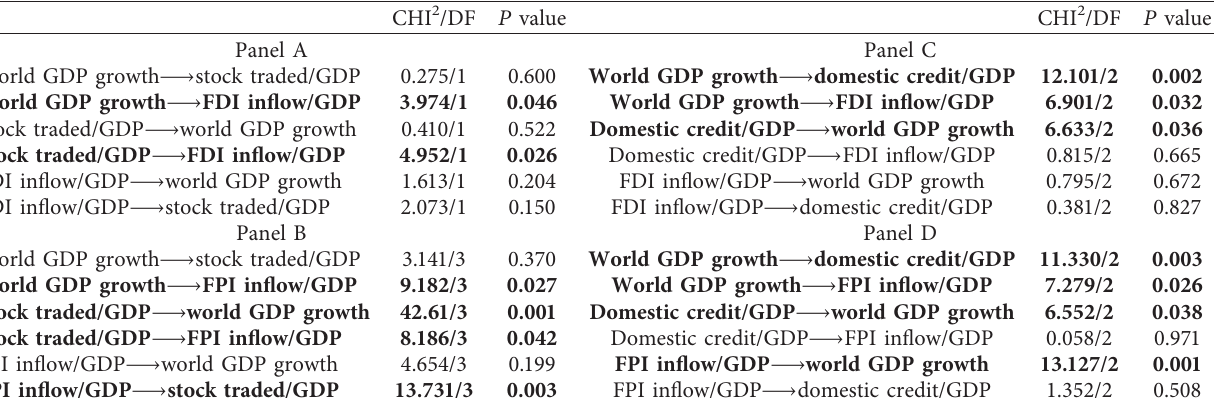
Table 4: Granger causality.